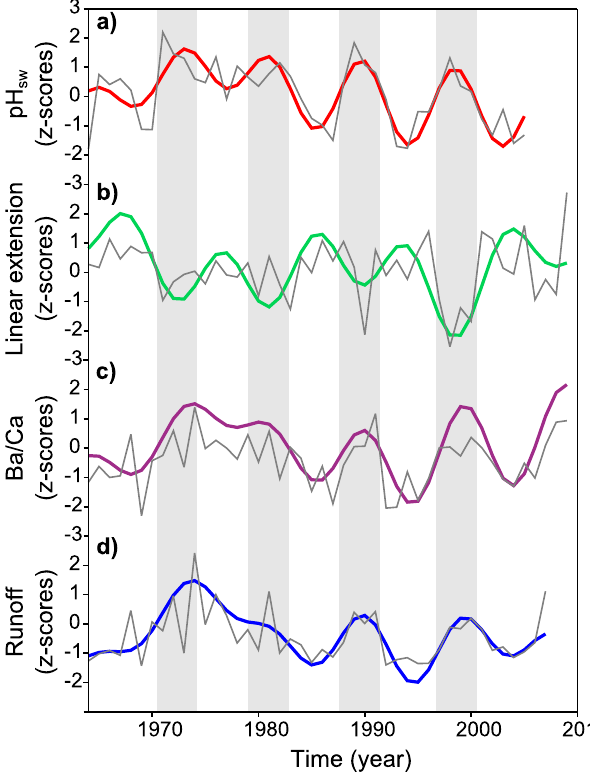
Figure 5. Normalized annual (grey) and smoothed (colored 8-year low-pass filter) time series for (a) the inner-shelf composite recon- structed pH sw obtained from δ 11 B carb coral records, (b) averaged linear extension of inner shelf in the central GBR (D’Olivo et al., 2013), terrestrial influx indicated by (c) discharge from the Bur- dekin River, and (d) coral Ba/Ca data from Pandora and Havannah Island (McCulloch et al.,